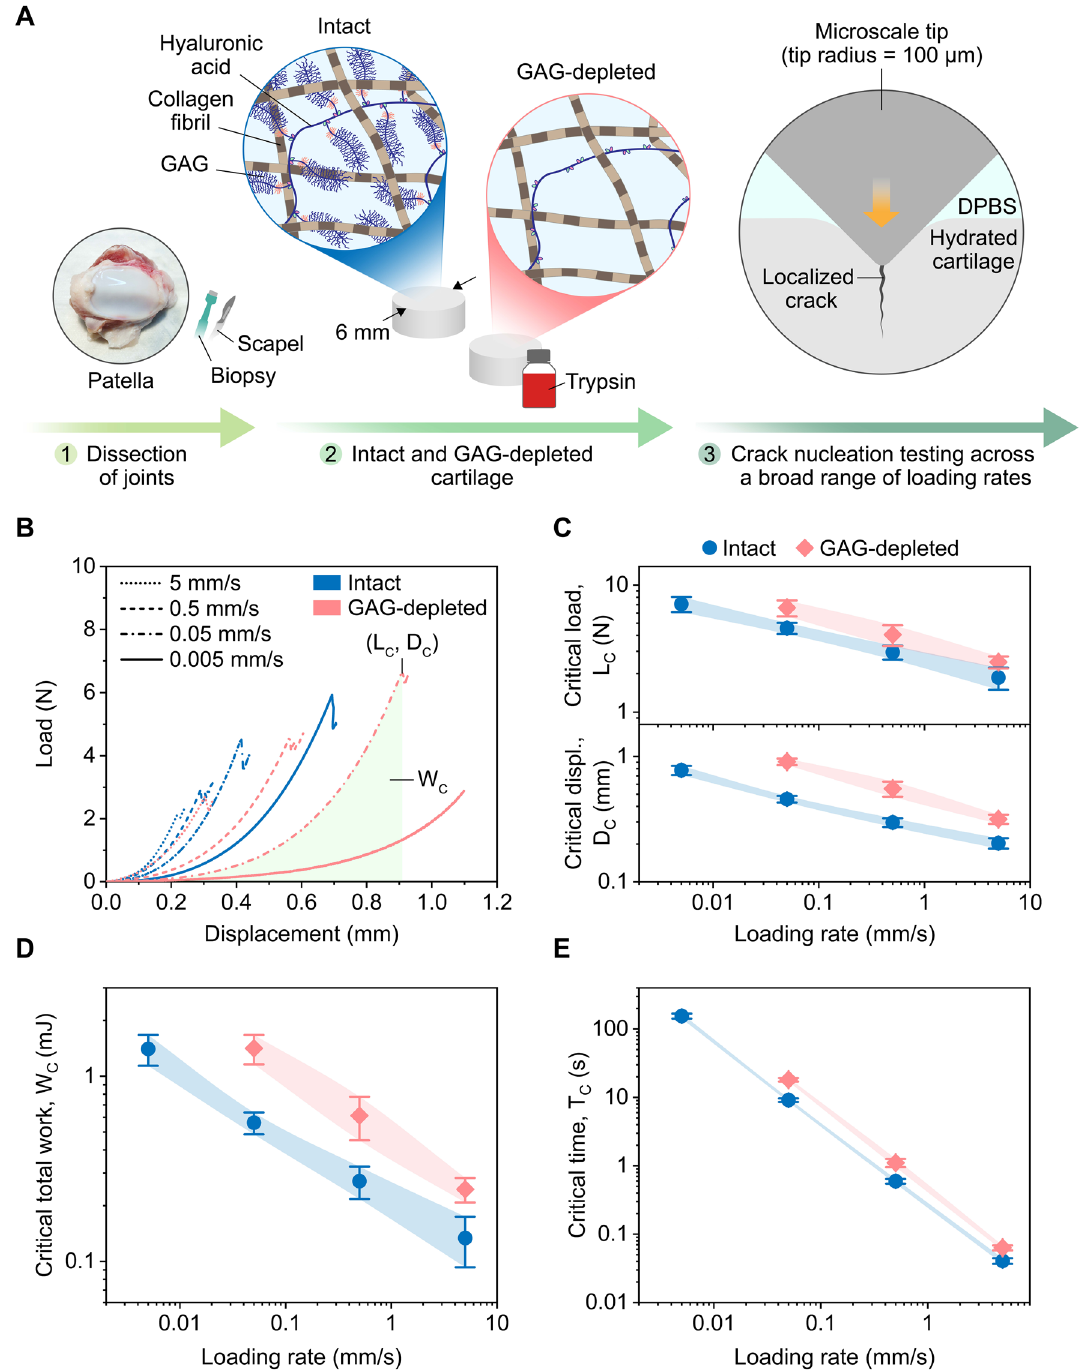
Figure 2. Crack nucleation in cartilage as a function of integrity across a broad range of loading rates. ( A ) Schematic illustrations of crack nucleation testing on intact and GAG-depleted cartilage via a microscale tip. ( B ) Representative load–displacement curves. Crack nucleation curves were analyzed with critical parameters: ( C ) critical load, critical displacement, ( D ) critical total work, and ( E ) critical time. The schematic diagrams are not to scale. Averages and standard deviations (connected with the modified Bézier curves) were reported (n =